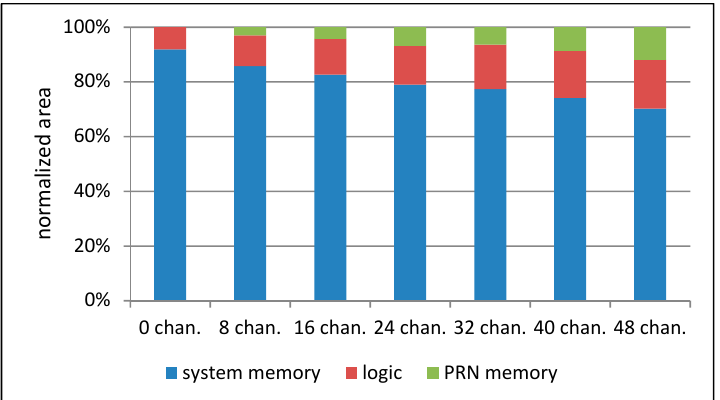
Figure 10. Normalized standard cells’ area as a function of GNSS tracking channels.